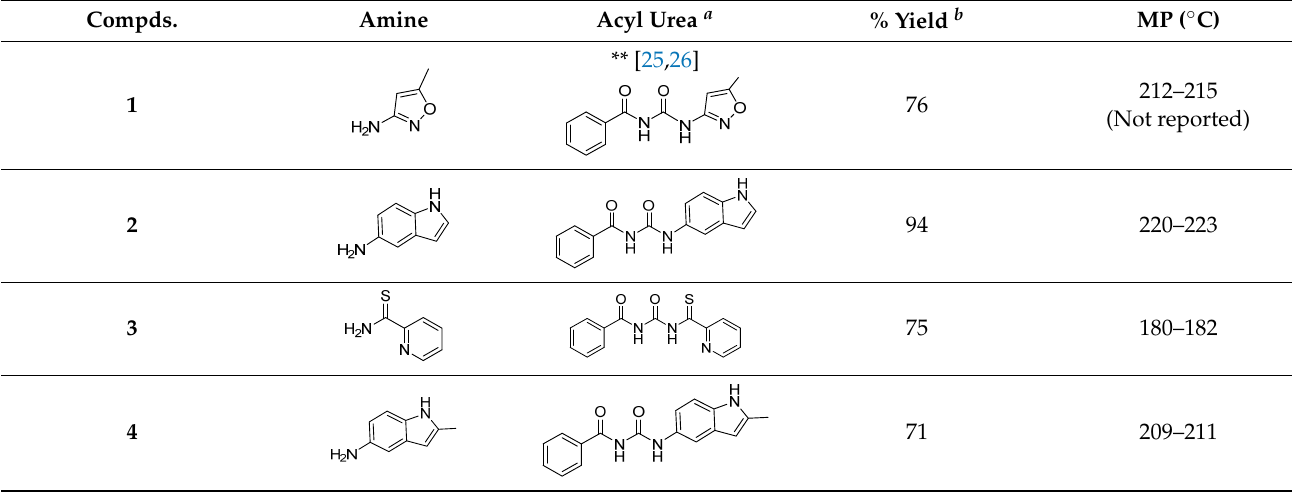
PD144418, the compounds were sent to the National Institute of Mental Health’s Psycho ‐ Table 1. Synthesized acyl ureas plus starting amines/amide/thioamides. a Characterized by 1 H, 13 C NMR, HRMS. b Yields of pure isolated products. ** Known compounds. Table 1. Synthesized acyl ureas plus starting amines/amide/thioamides. a Characterized by 1 H, 13 C Table 1. Synthesized acyl ureas plus starting amines/amide/thioamides. a Characterized by 1 H, 13 C Table 1. Synthesized acyl ureas plus starting amines/amide/thioamides. a Characterized by 1 H, 13 C NMR, HRMS. b Yields of pure isolated products. ** Known compounds. Table 1. Synthesized acyl ureas plus starting amines/amide/thioamides. a Characterized by 1 H, 13 C Table 1. Synthesized acyl ureas plus starting amines/amide/thioamides. a Characterized by 1 H, 13 C Table 1. Synthesized acyl ureas plus starting amines/amide/thioamides. a Characterized by 1 H, 13 C Table 1. Synthesized acyl ureas plus starting amines/amide/thioamides. a Characterized by 1 H, 13 C NMR, HRMS. b Yields of pure isolated products. ** Known compounds. NMR, HRMS. b Yields of pure isolated products. ** Known compounds. NMR, HRMS. b Yields of pure isolated products. ** Known compounds. NMR, HRMS. b Yields of pure isolated products. ** Known compounds. NMR, HRMS. b Yields of pure isolated products. ** Known compounds. NMR, HRMS. b Yields of pure isolated products. ** Known